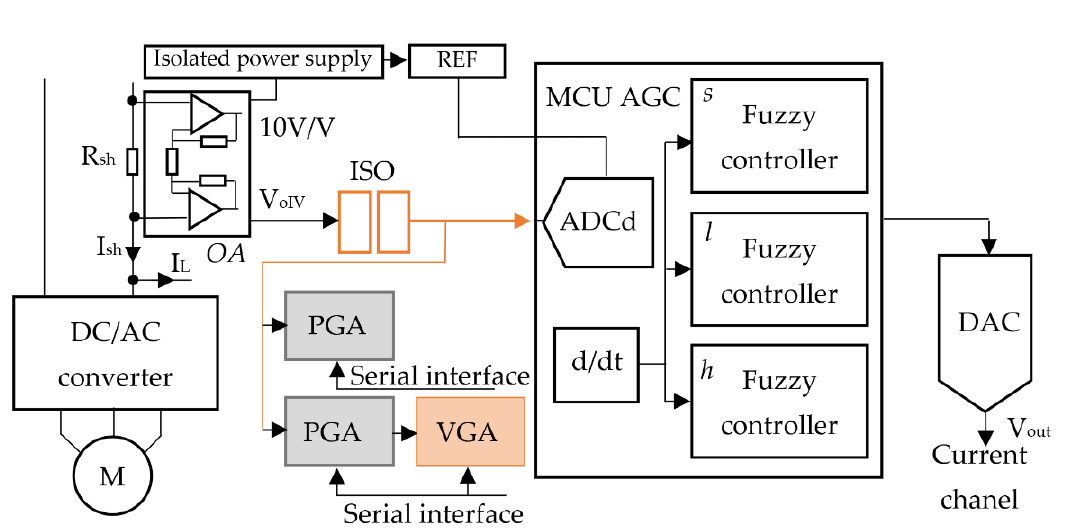
Figure 4. Structure AGC of the fuzzy controller in the current measurement.